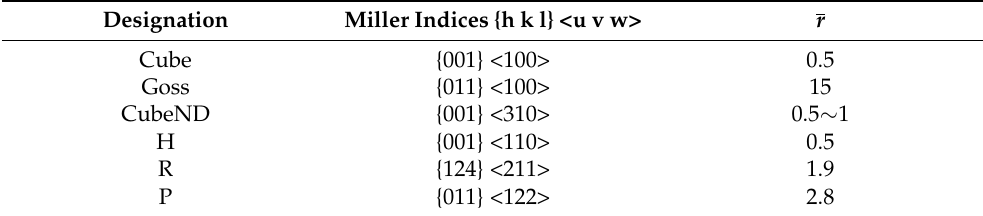
Table 3. Calculated r values of typical recrystallized texture components [26].